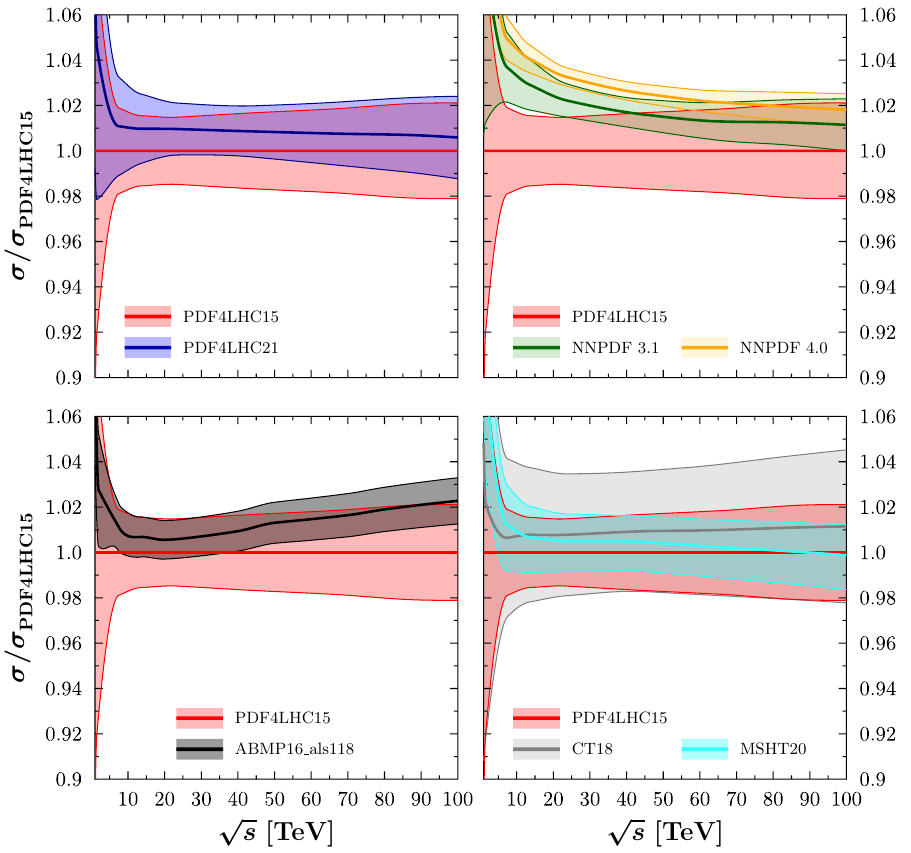
Figure 17 . Dependence on the choice of the PDF set of the inclusive cross section at N 3 LO in QCD, for the associated Higgs production with a W + boson at a proton-proton collider using a √ dynamical central scale, as a function of the proton-proton c.m. energy s in TeV. The results are normalized to the central PDF4LHC15 PDF set and the 68% CL PDF uncertainties are represented by bands for all sets and calculated according to the prescription of ref. [67]. The comparison is between PDF4LHC15 and: PDF4LHC21 (upper left panel); NNPDF 3.1 and NNPDF 4.0 (upper right panel); ABMP16 als118 (lower left panel); CT18 and MSHT 20 (lower right